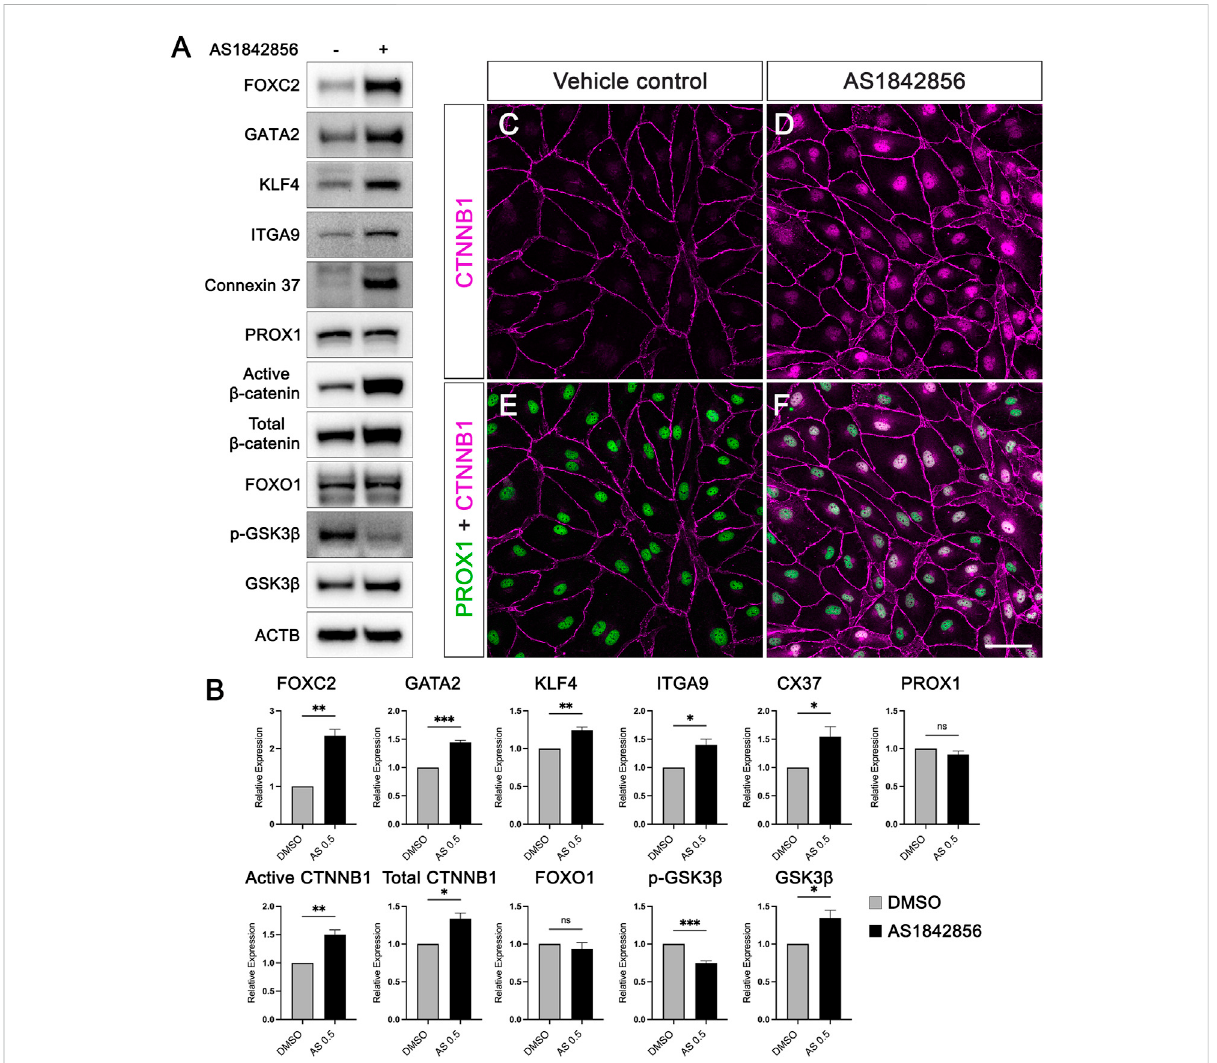
FIGURE 2 AS1842856 elevates protein expression of valve-forming genes and promotes β -catenin nuclear localization in cultured hdLECs. (A) hdLECs were cultured under static conditions and treated for 48 h with 0.5 µM DMSO (vehicle control) or 0.5 µM AS treatment. Thereafter, proteins were extracted,andtheWesternblotwasperformedfortheindicatedproteins.ACTBistheloadingcontrol. (B) Quanti fi cationresultsofindicatedproteins intheWesternblotfromthreeindependentexperiments. (C – F) ImmunostainingofculturedhdLECsfor PROX1 andCTNNB1proteins.Allvalues aremean±SEM. n =3experimentrepeats;ns=notsigni fi cant;* p ≤ 0.05,** p ≤ 0.01,*** p ≤ 0.001.Vehiclecontrol:0.5 µMDMSOfor48 htreatment. AS1842856: 0.5 µM AS1842856 for 48 h treatment. The cells were stained for PROX1 (green) and CTNNB1 (purple). (E, F) Merged images for PROX1 and CTNNB1. Scale bar is 50 μ